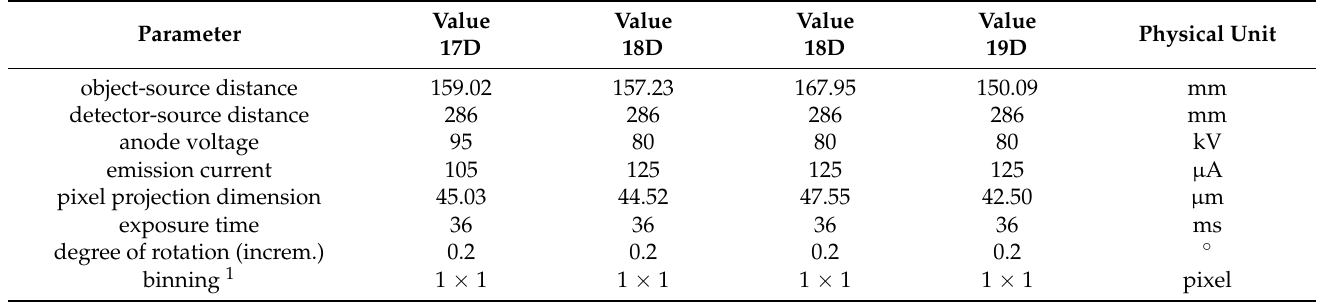
Table A14. Values of set parameters on SkyScan